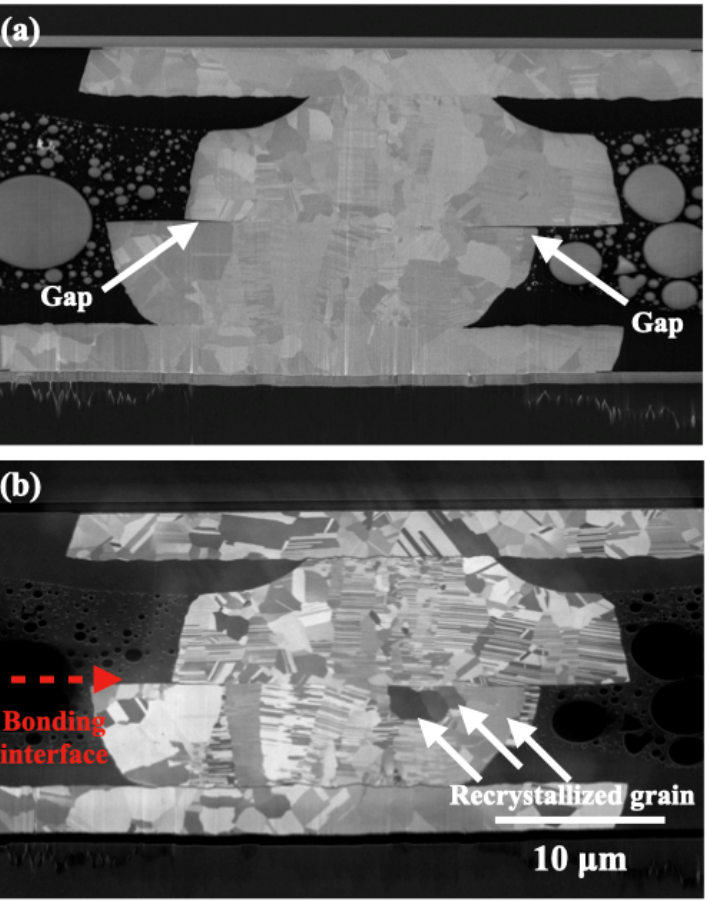
Figure 8. Process profile of temperature and bonding force vs. bonding time in the first step with an applied bonding force of 31 MPa.